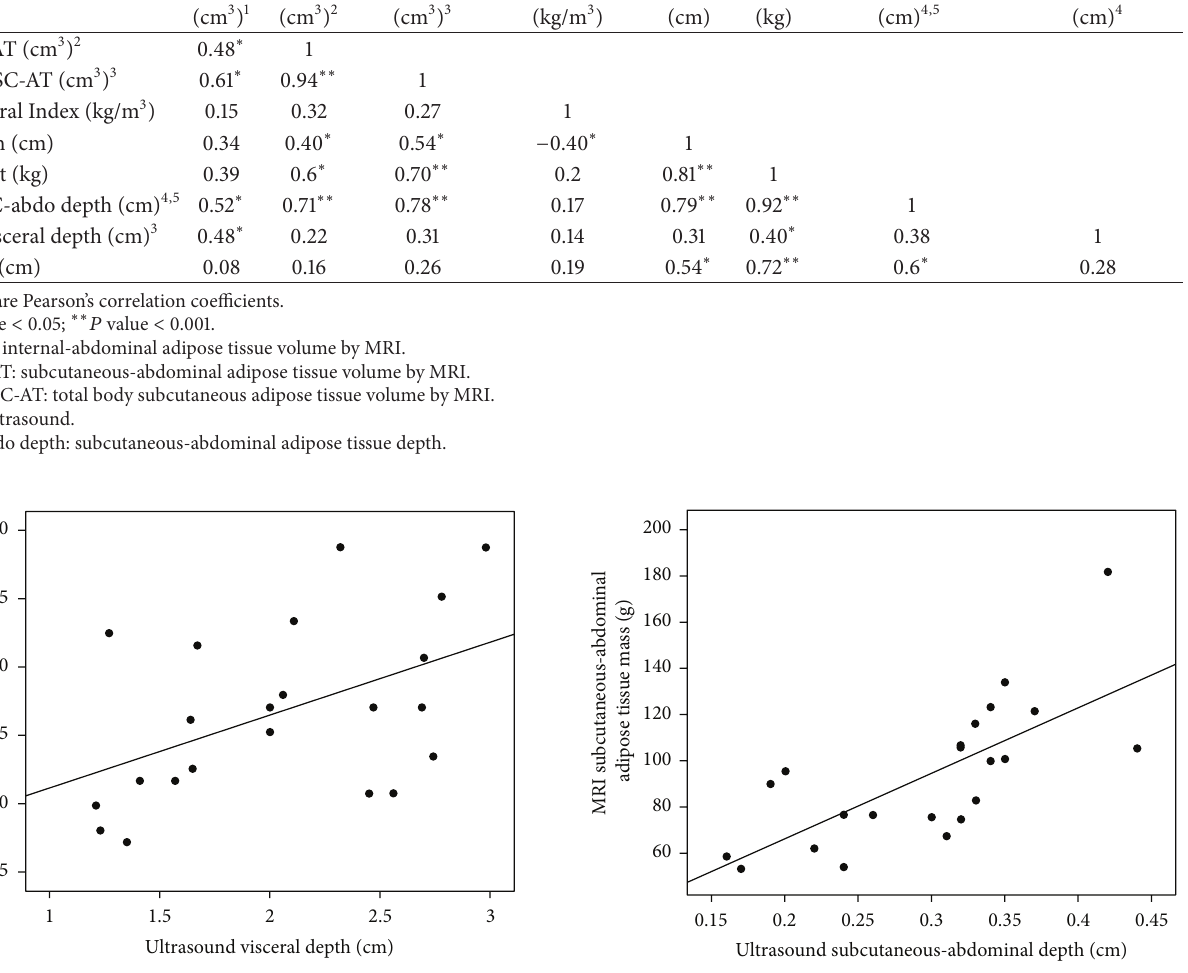
Figure 2: Scatterplot of ultrasound subcutaneous-abdominal depth against MRI subcutaneous-abdominal adipose tissue (SCAT-AT) mass. Correlation coefficient: 𝑟 = 0.71 ; 𝑃 < 0.001